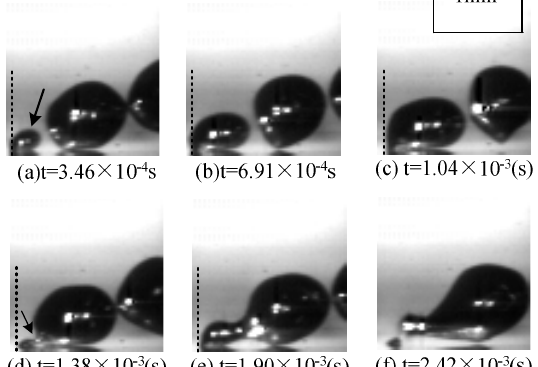
Fig. 4 Process of bubble separation (coalescent bubble)